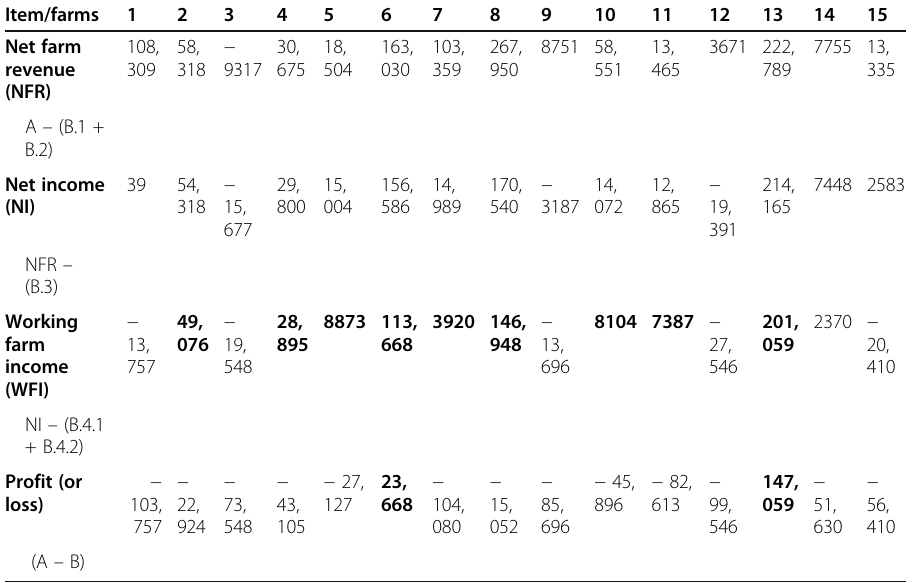
Table 4 Results from balance sheet